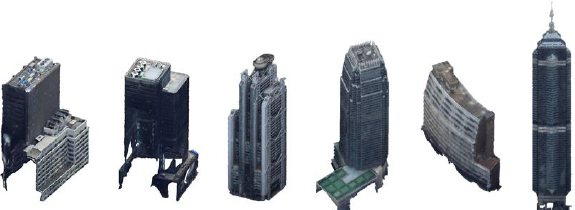
Figure 6. Building point clouds with various complex structures and missing